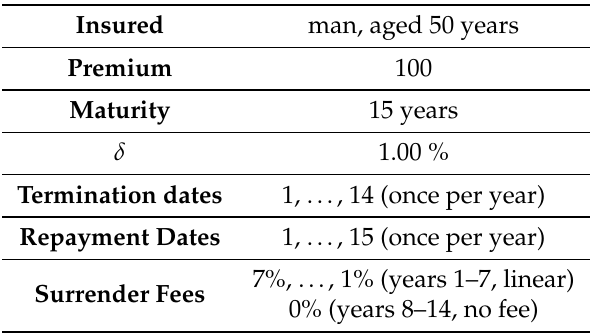
Figure 7. First-Year Surrender Probability 1%–4.88% ( a ) and 4.88%–9.52% ( b ). Table 6. Specification of Variable Annuity (VA)